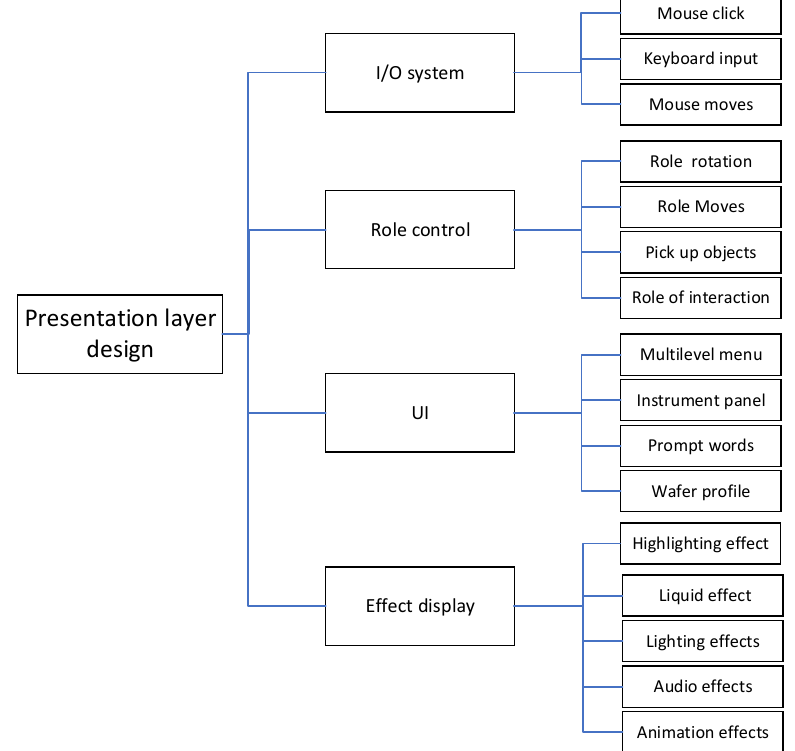
Figure 9. Overall functional structure diagram of the interaction design.